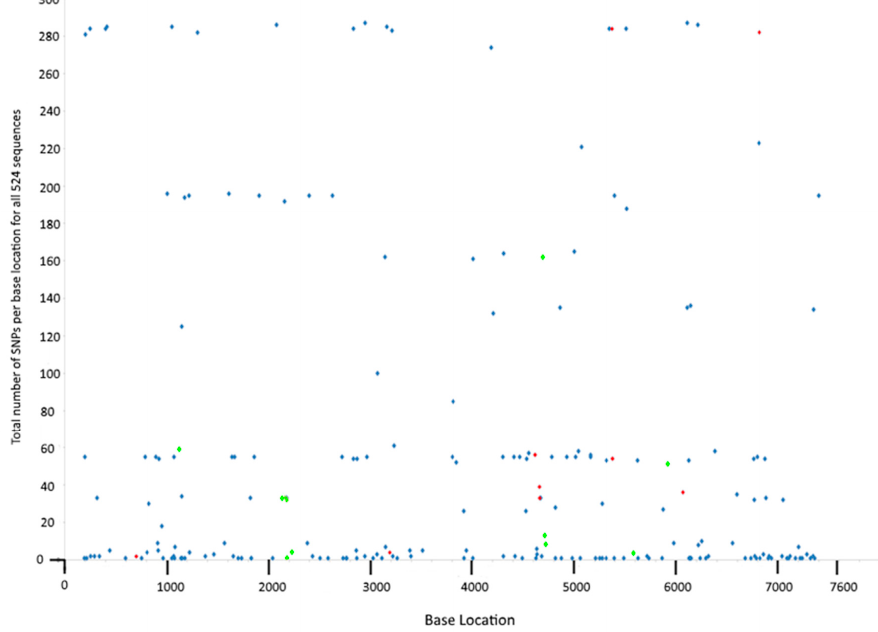
Figure 1. Number of sequences carrying each of the 199 SNP loci identified. Blue dots indicated bi-allelic SNP locations, red dots indicate tri-allelic SNP locations, and green dots are intergenic SNPs.